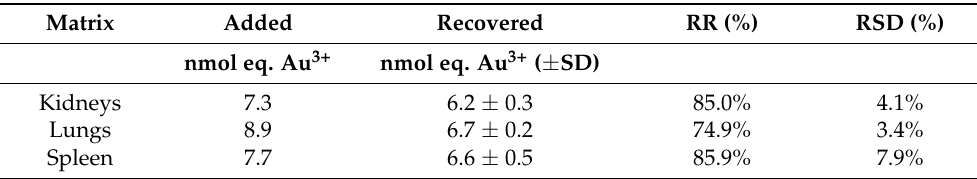
Table 4. Gold RR and repeatability obtained in other rat organs. Matrix